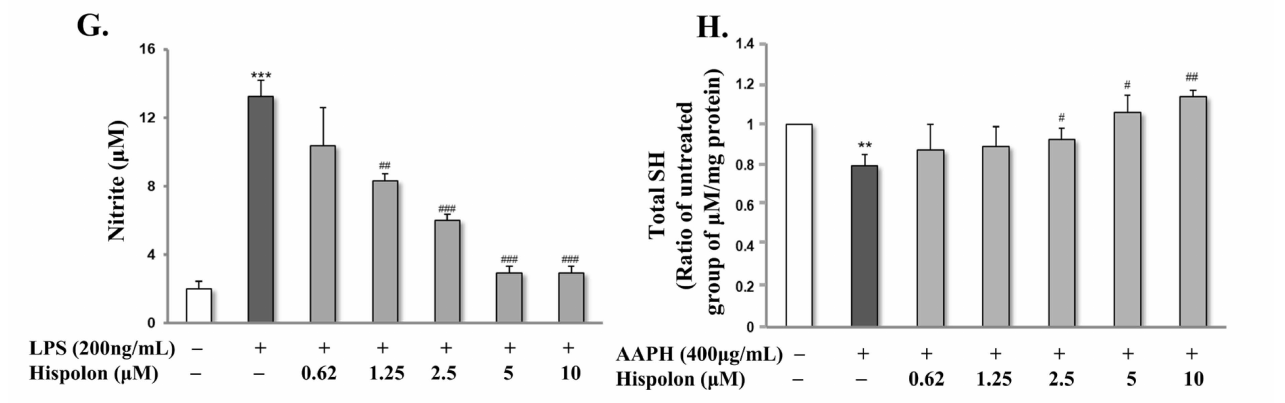
Figure 2. In vitro and intracellular ROS/RNS-scavenging activity of hispolon. Menadione and FeSO 4 /H 2 O 2 were used as sources of free radicals. Hispolon was administrated at concentrations of 1.25, 2.5, 5, or 10 µ M to the ( A ) superoxide and ( B ) hydroxyl radical groups. NAC (250 µ M) and AAPH (400 µ g/mL) were used as positive controls. The intracellular ROS level was determined using a fluorescence reader and flow cytometer. ( C ) AAPH (400 µ g/mL)- and ( D ) LPS (200 ng/mL)- stimulated cells were incubated with DCFH-DA in 96-well plates and measured using a fluorescence reader. ( E , F ) LPS-stimulated cells were assessed by measuring DCF fluorescence in gated cells using a flow cytometer, as shown in the histogram and bar graph. ( G ) Griess reagent that converts nitrate to nitrite was utilized to detect NO production. The cells were preincubated with 0.62, 1.25, 2.5, 5, or 10 µ M hispolon for 1 h and then treated with 200 ng/mL LPS for 12 h. The culture supernatants were subsequently collected, and nitrite levels were analyzed. ( H ) The total SH group content after hispolon treatment in AAPH-treated RAW264.7 cells were measured using the DTNB assay. The data are presented as the means of three separate experiments performed in triplicate ( n = 3). Significance was analyzed using one-way ANOVA; * p < 0.05, ** p < 0.01 and *** p < 0.001 vs. control group; # p < 0.05, ## p < 0.01, and ### p < 0.001 vs. AAPH- or LPS-treated